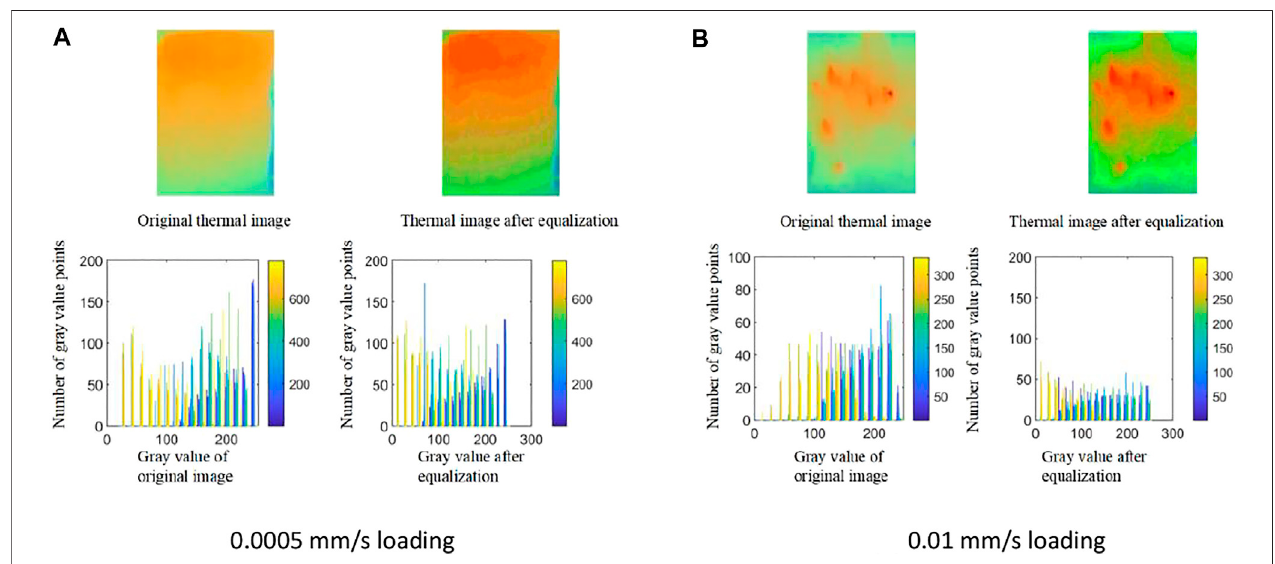
FIGURE 11 | Histogram equalization for phosphate rock specimens under different loading rates. (A) 0.0005 mm/s loading and (B) 0.01 mm/s loading.